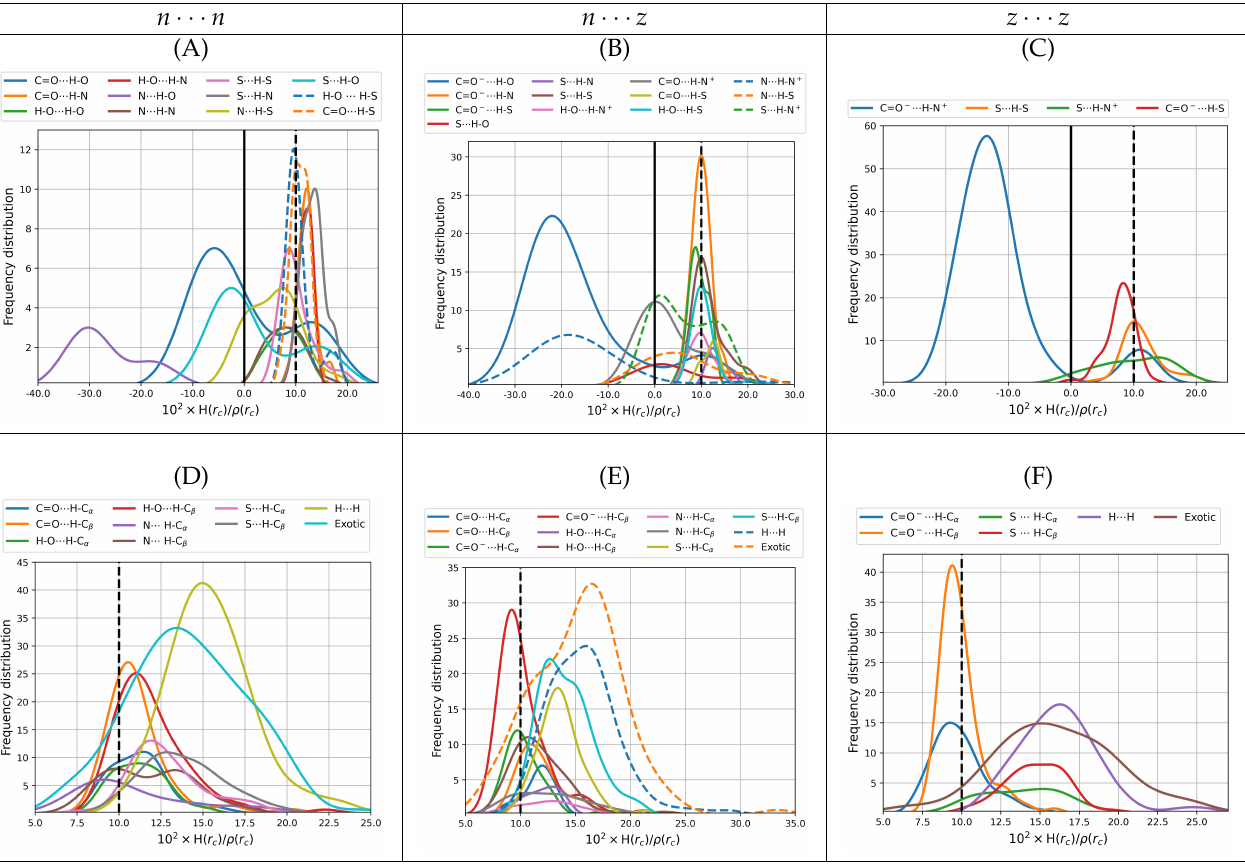
Figure 6. Bond degree parameters for intermolecular contacts for all dimers of cysteine found in this work. The top row shows only primary hydrogen bonds including salt bridges. The bottom row shows secondary hydrogen bonds, dihydrogen bonds, and all exotic interactions. The left column is reserved for the n · · · n dimers (subfigures ( A , D )), the middle column for n · · · z (subfigures ( B , E )) and the right column for z · · · z (subfigures ( C , F )). All values taken from the B3LYP–D3/6–311++G( d , p ) potential energy surfaces with water represented as a continuum solvent. Solid vertical lines mark the QTAIM boundaries separating locally stabilizing from the locally destabilizing interactions. Dashed vertical lines mark the reference value for the gas phase water